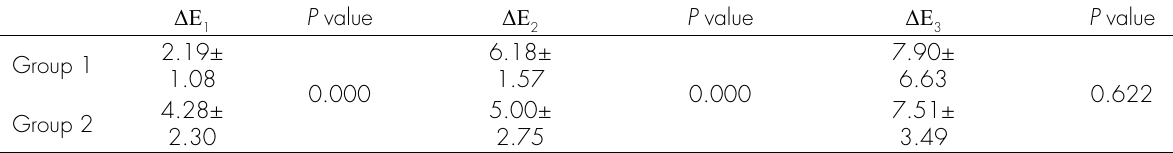
Table IV. Inter group comparison of ΔΕ values at T0, T1 and T2 between Groups 1 and 2 (N = 89)( p < 0.05).